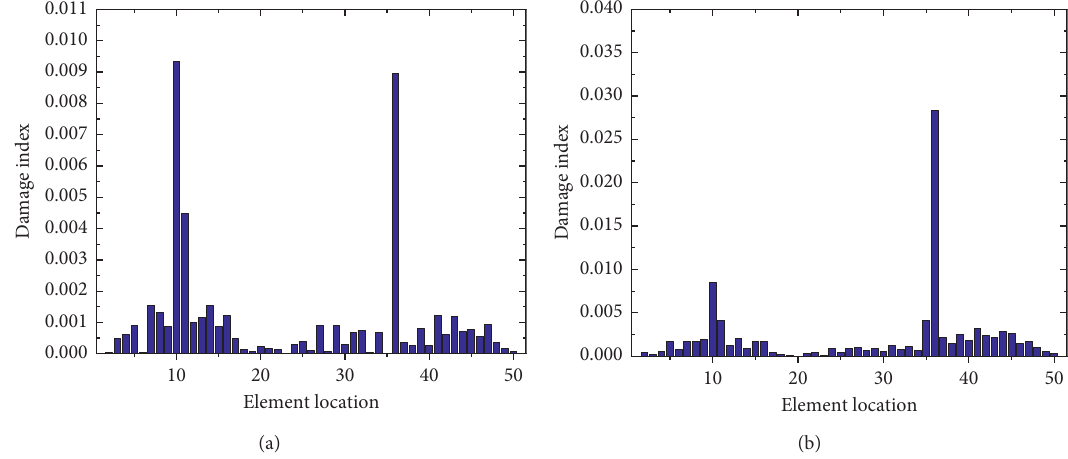
Figure 11: Damage detection results of double-damage cases. (a) Case study 7. (b) Case study 8.